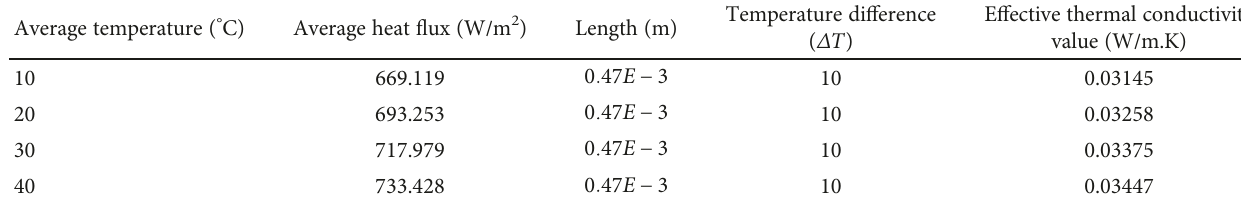
Table 6: The numerical solution results for the expanded polystyrene with the density value of 25kg/m 3 . Average temperature ( ° C)